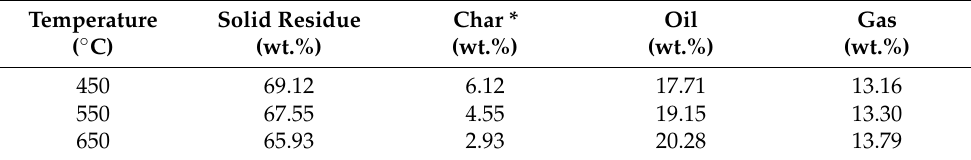
Table 2. Mass balance of microwave pyrolysis of carbon fibre epoxy prepreg.